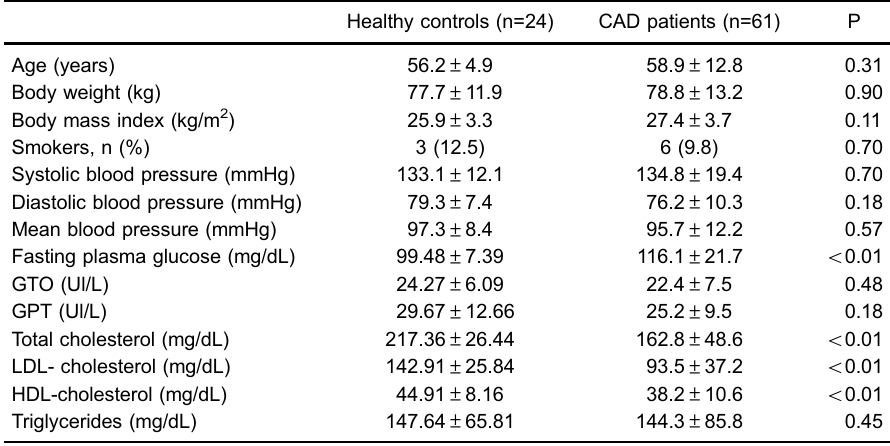
Table 1. Baseline clinical characteristics of the male coronary artery disease (CAD) patients and healthy controls.